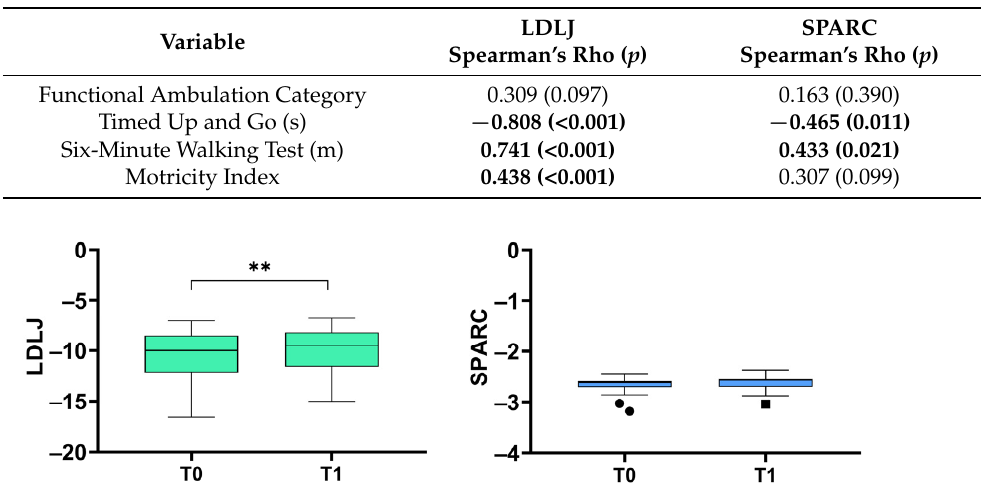
Figure 3. Responsiveness analysis: ability of the two metrics (log dimensionless jerk, LDLJ, and spectral arc length, SPARC) in following the clinical improvement after a rehabilitation intervention. The asterisks indicate a statistically significant difference (**: p < 0.01).